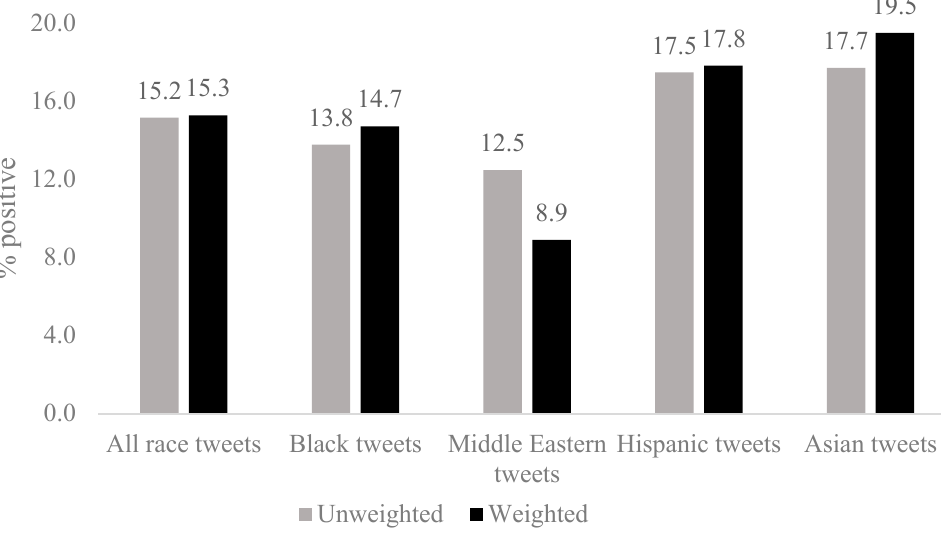
Figure 2. Descriptive characteristics for sentiment of 2015–2016 tweets using race-related terms. Data sources: 1,249,653 geolocated tweets from the 48 contiguous United States plus the District of Columbia collected between April 2015–March 2016. Number of followers was used to calculate weighted percentages.